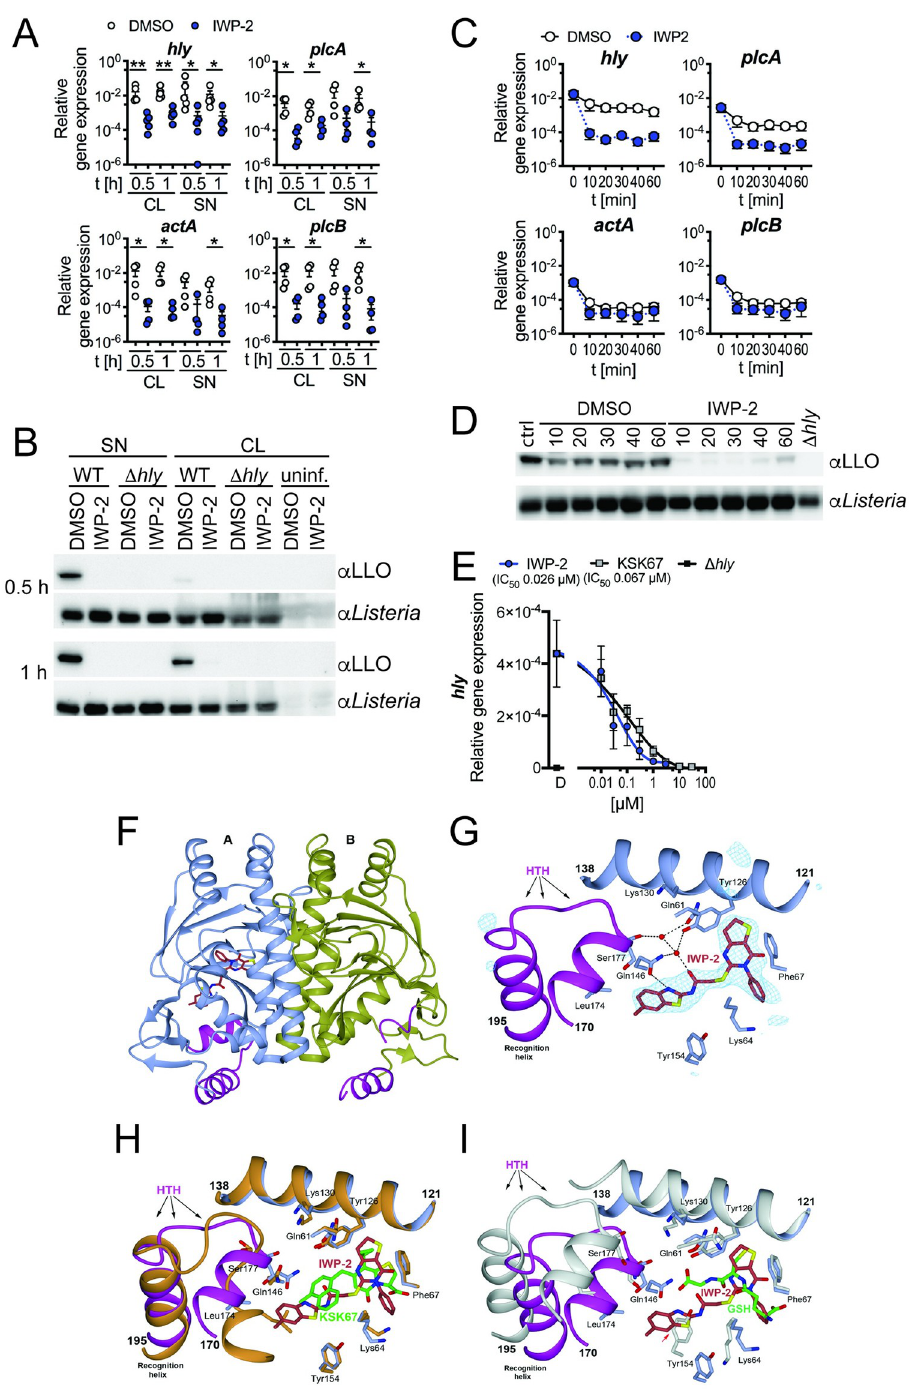
Fig 1. Small molecule occupation of the PrfA coactivator site impairs PrfA-driven virulence gene expression. (A) Significantly diminished expression of L . monocytogenes virulence genes determined by quantitative RT-PCR in cell lysates (CL) and supernatants (SN) of RAW246.7 macrophages after 0.5 and 1 h of infection in the presence of IWP-2, as compared to DMSO-treated control cells. Data are from 4–5 independent experiments; means +/- sem are indicated. Groups at each condition and time point were compared by Mann-Whitney test. (B) Cell lysates and supernatants of cells infected as in (A) show diminished L . monocytogenes LLO protein expression in the presence of IWP-2 compared to DMSO-treated controls, as determined by western blot. LLO-deficient Δ hly L . monocytogenes served as control. Data are representative of 3 independent experiments with similar results. (C) IWP-2 addition rapidly diminished PrfA-controlled L . monocytogenes virulence gene expression in brain heart infusion broth cultures